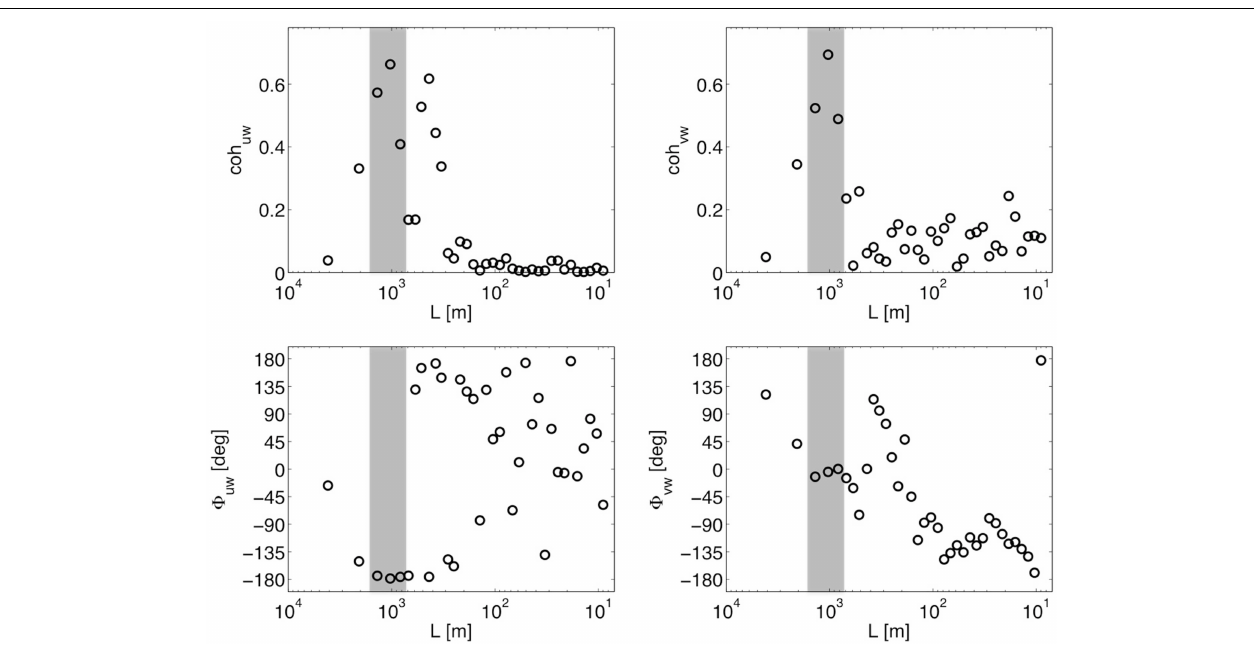
FIGURE 7 | As in Figure 6, except for the lower ABL flight leg